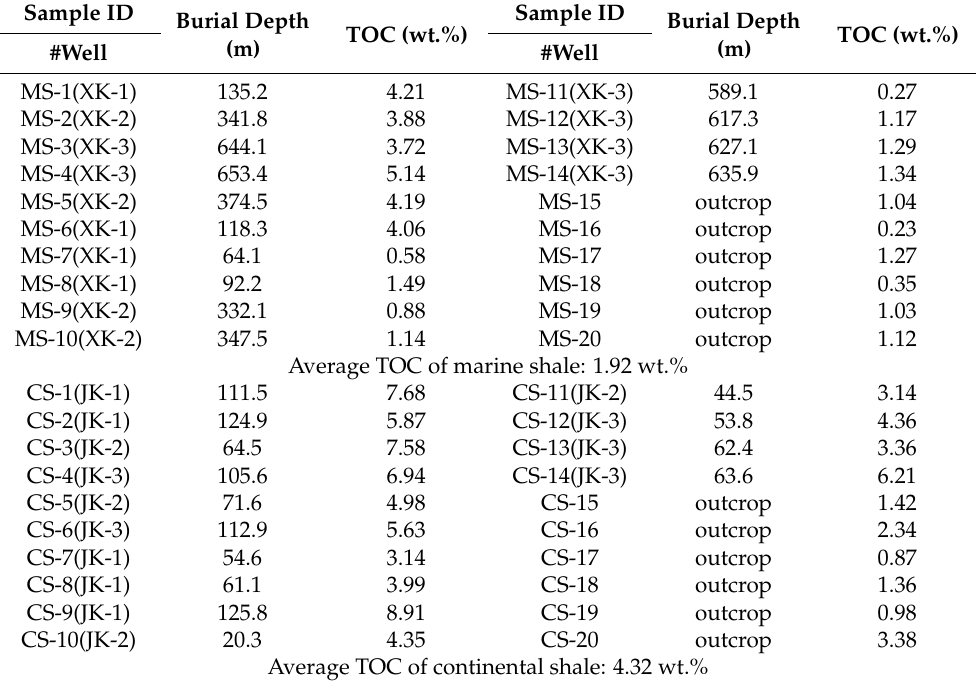
Table 1. Sample information of well, burial depth, and TOC